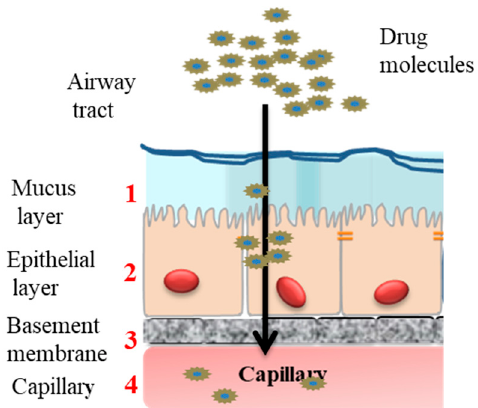
Figure 2. Barriers against drug absorption in pulmonary drug administration including; (1) mucus layer, (2) epithelial layer, (3) interstitium and basement membrane, and (4) capillary endothelium.